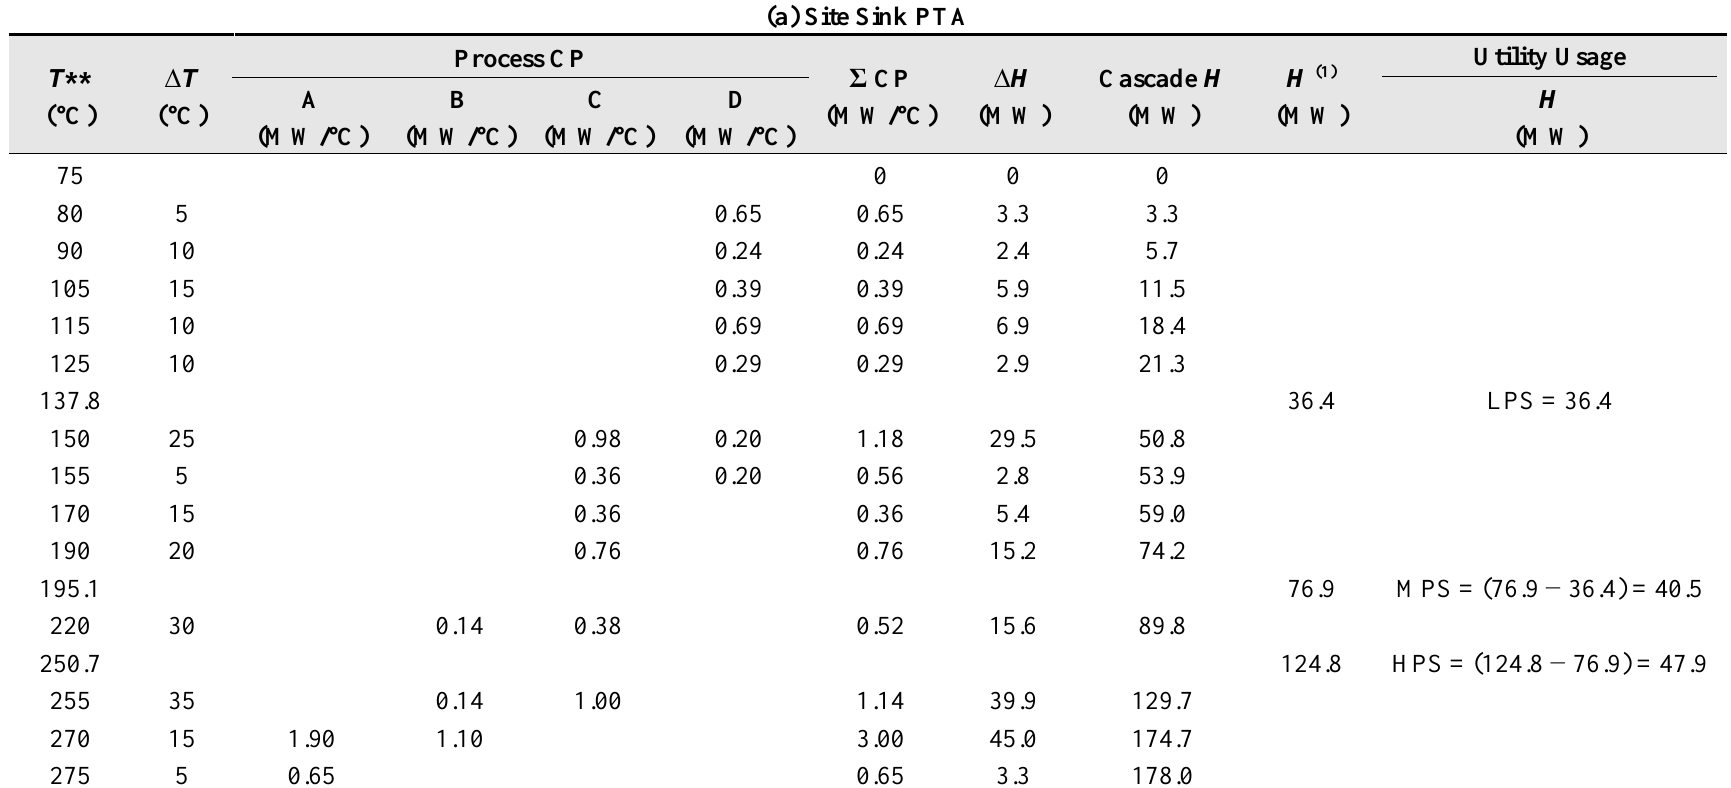
Table 4. TS-PTA for Site Source and Site Sink with utilities usage and